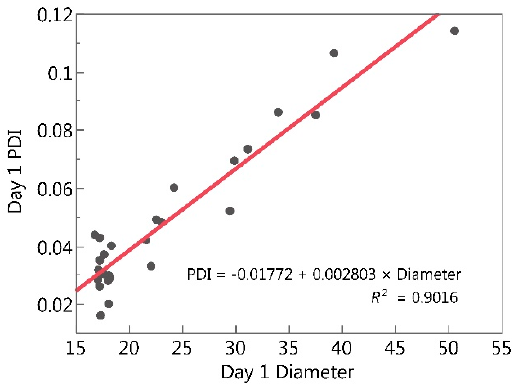
Figure4. Figure 4. Single linear regression of day 1 microemulsion PDI as a function of day 1 microemulsion diameter.